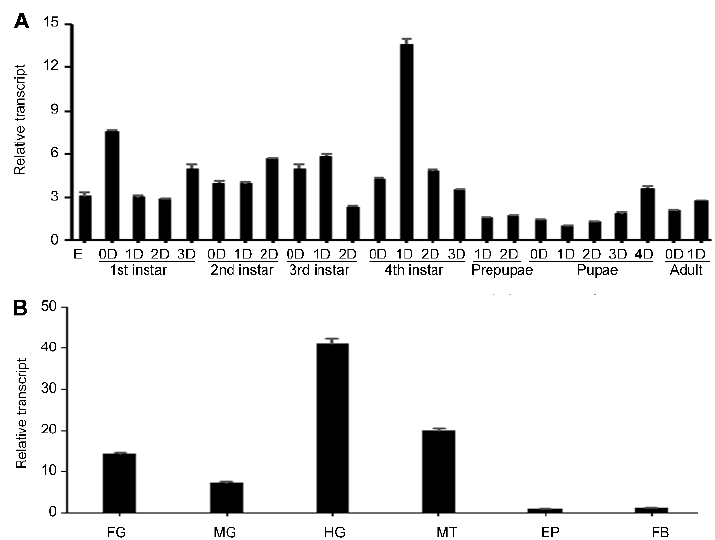
Figure 1. Temporal ( A ) and tissue ( B ) transcription patterns of HvvATPaseG in Henosepilachna vigintioctopunctata . For temporal expression analysis, RNA templates were derived from eggs (day 3), the larvae from the first through the fourth instars, prepupae, pupae and adults (D0 indicated newly ecdysed larvae or pupae, or newly emerged adults). For tissue expression analysis, the relative transcripts were measured in the foregut (FG), midgut (MG), hindgut (HG), Malpighian tubules (MT), epidermis (EP) and fat body (FB) of the day 1 final instar larvae. For each sample, three independent pools of 20–30 individuals were measured in technical triplicate using qRT-PCR. The values were calculated using the 2 − ∆∆ CT method. The relative transcripts are the ratios of copy numbers in different developing stages relative to egg, or those in different tissues relative to EP, which are set as 1. The columns represent averages with vertical lines indicating